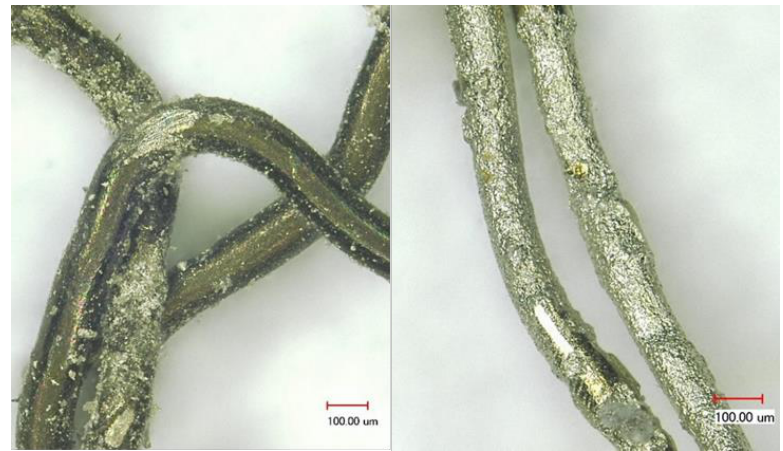
Figure 7. Silver cementation on nickel threads.